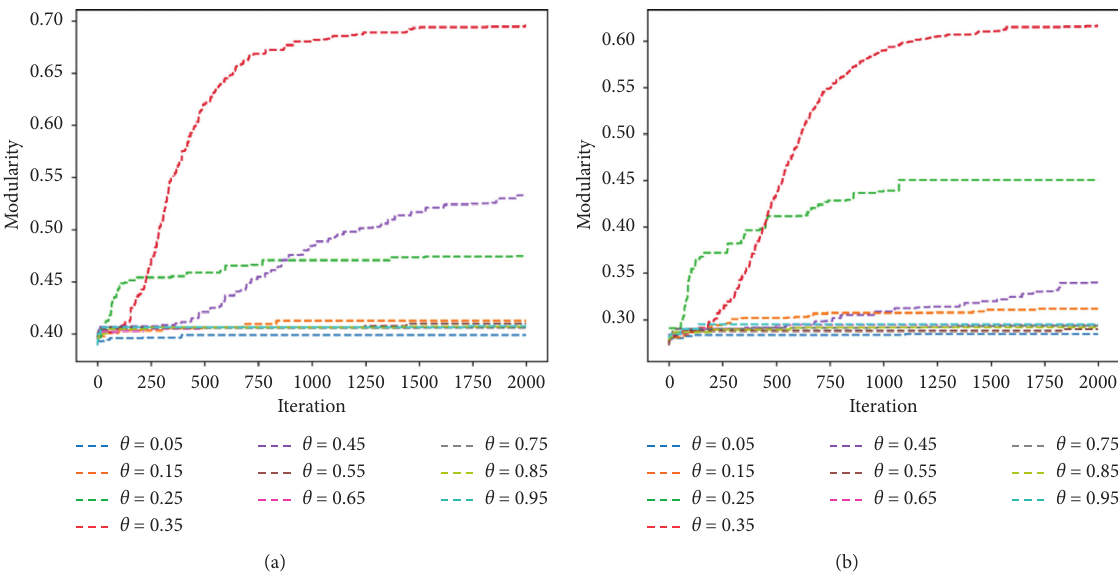
Figure 4: Evolution results of two different networks under different similarity thresholds. (a) Evolution process of BA network. (b) Evolution process of ER network.